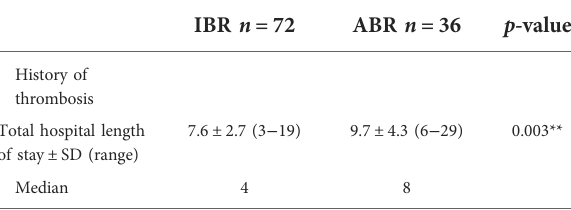
TABLE 1 Sociodemographic and clinical characteristics of all patients who underwent primary breast